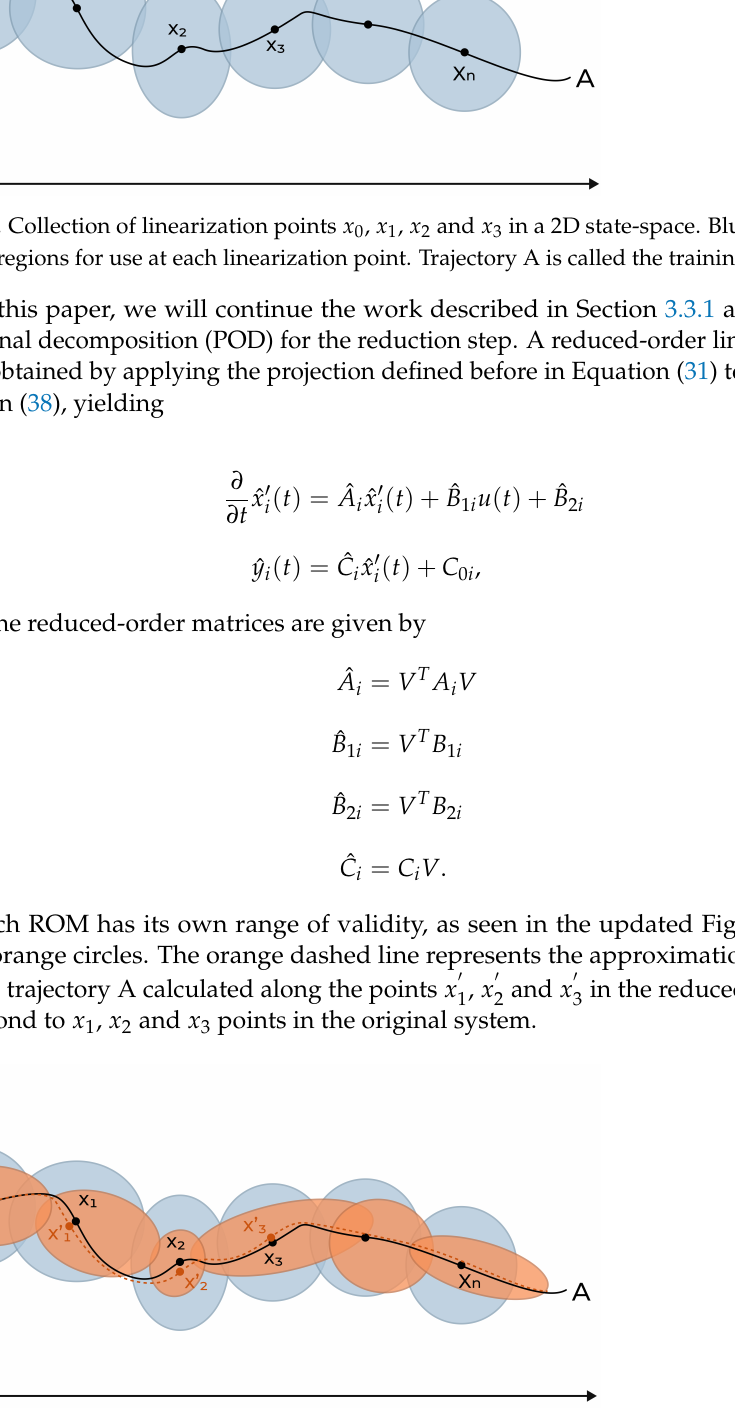
, x (cid:48) and x (cid:48) , along with the previously highlighted lin- 2 3 1